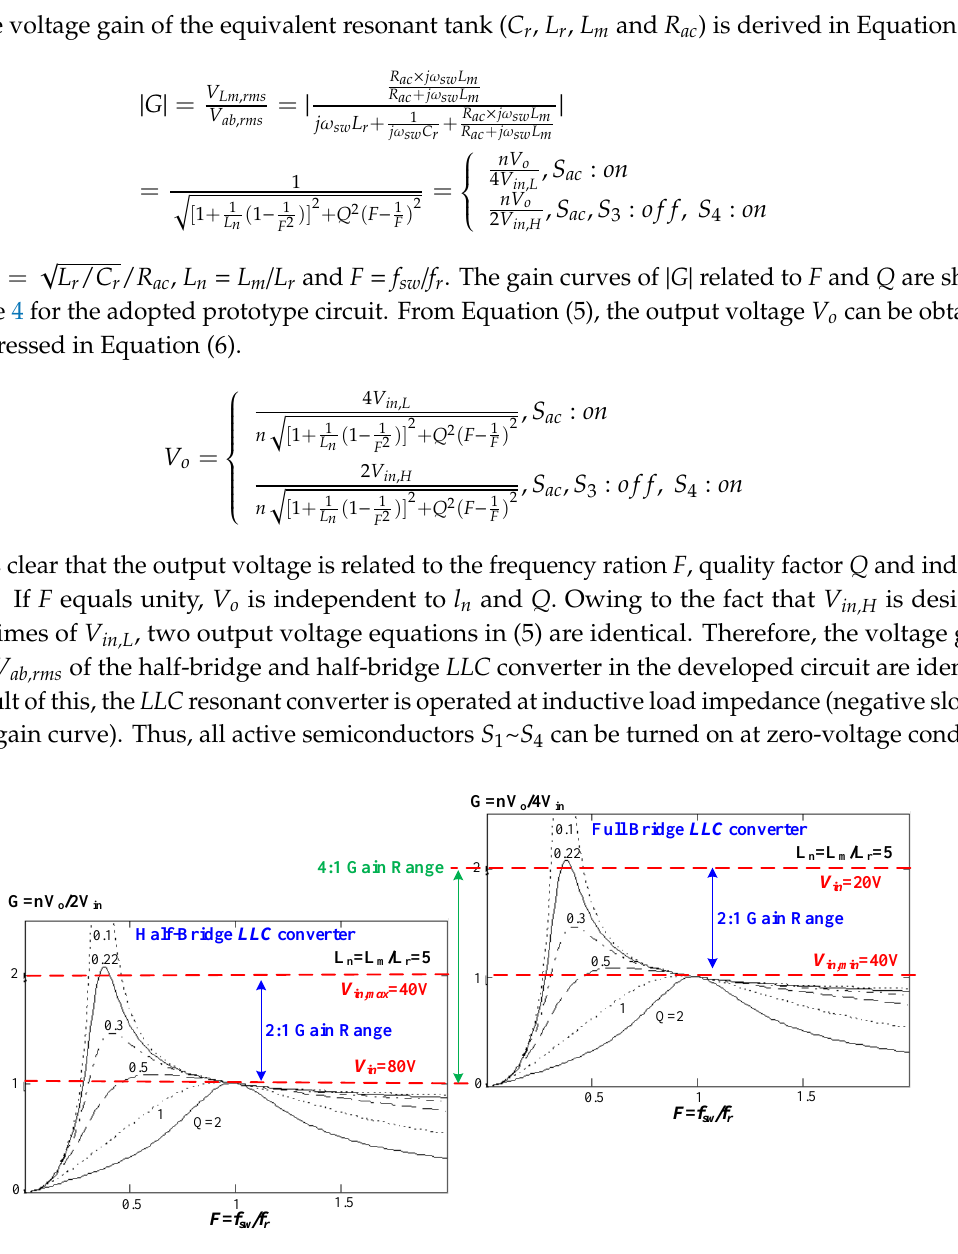
Figure 4. Gain curves of presented converter at V in = 20~80 V.